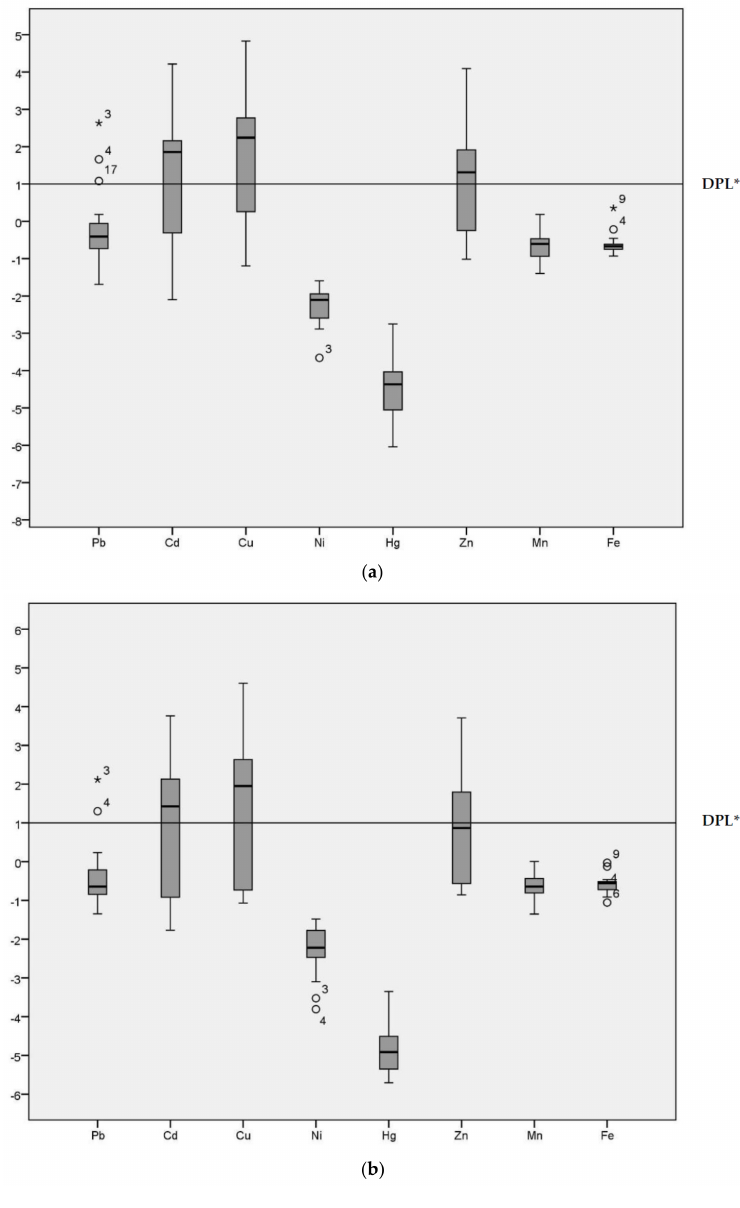
Figure 2. Geo-accumulation Index (I geo ) values of heavy metals in sediments of samples